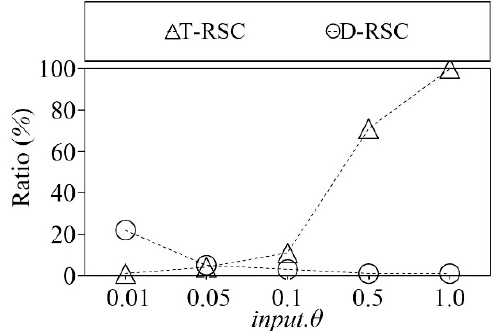
Figure 18. Ratio of RSC result on synthetic dataset with varied input. θ .